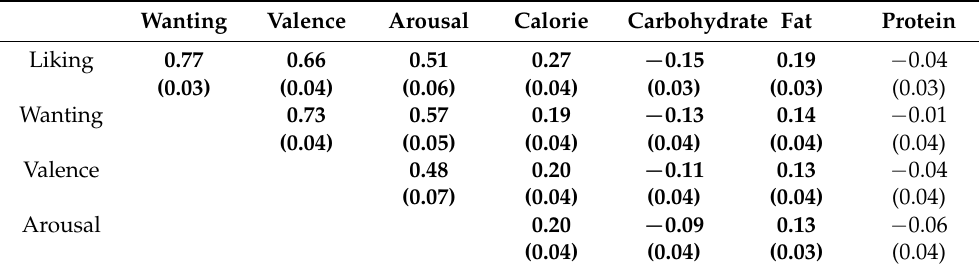
Table 1. Mean (with standard error) correlation coefficients among subjective ratings and between subjective ratings and nutritional information